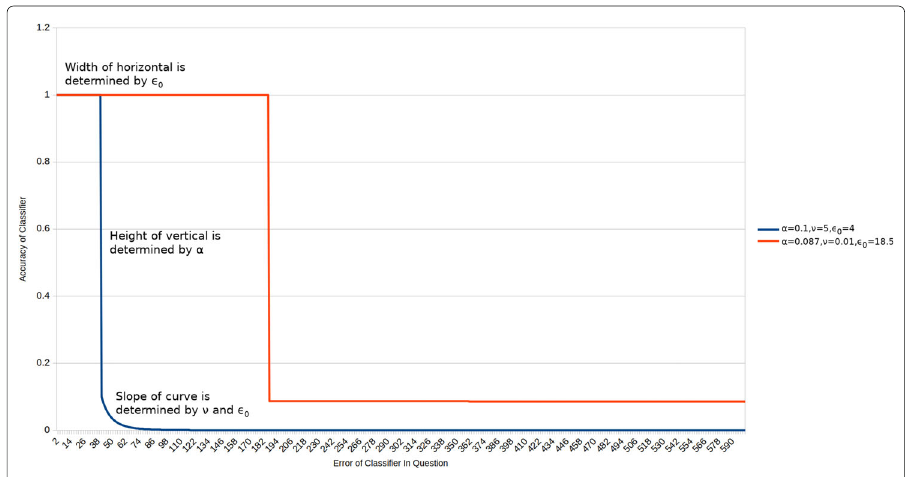
Fig. 6 A chart showing the relationship between a classifier’s error and its accuracy for the XCS classifier accuracy function. Accuracy is defined as: α((cid:3) j /(cid:3) 0 ) − ν where (cid:3) j is the error of classifier j. This chart is based on that presented by Butz et al. Fig. 1 (Butz et al.